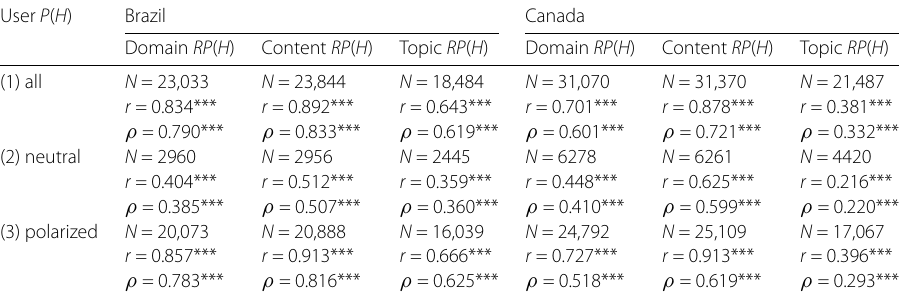
Table 3 Correlation between User P ( H ) and retweeted Domain, Content or Topic RP ( H ) User P ( H